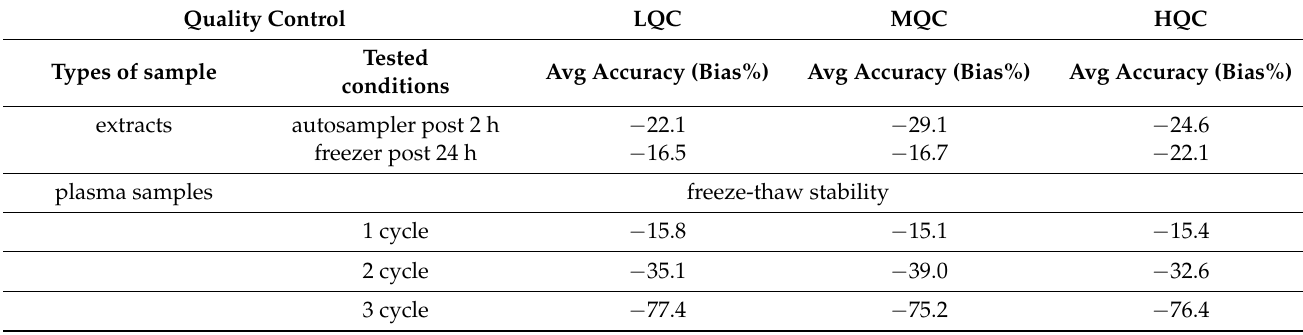
Table 5. Stability of C at different storage conditions. In our study, we tested both the extracts and the plasma samples (according to our routine